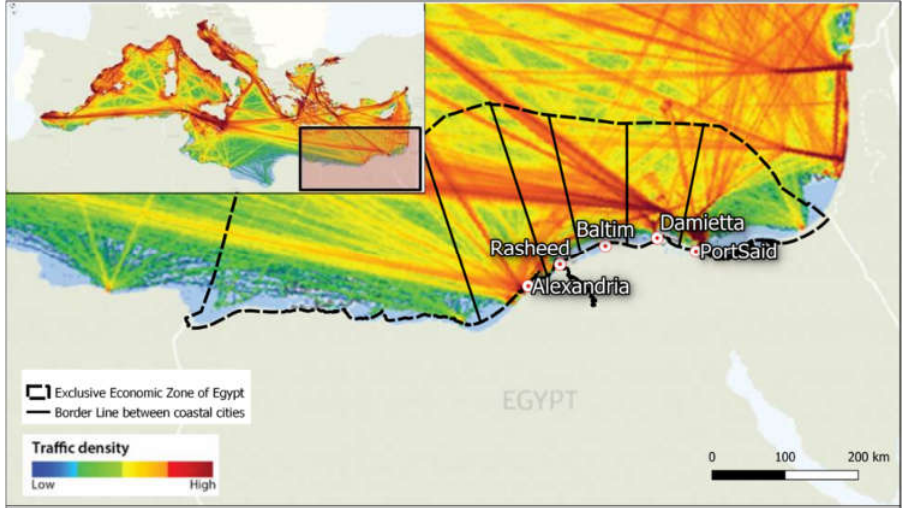
Figure 5. Density of maritime traffic in the Mediterranean Sea in 2017 [12]. Figure 4. Density of maritime traffic in the Mediterranean Sea in 2017